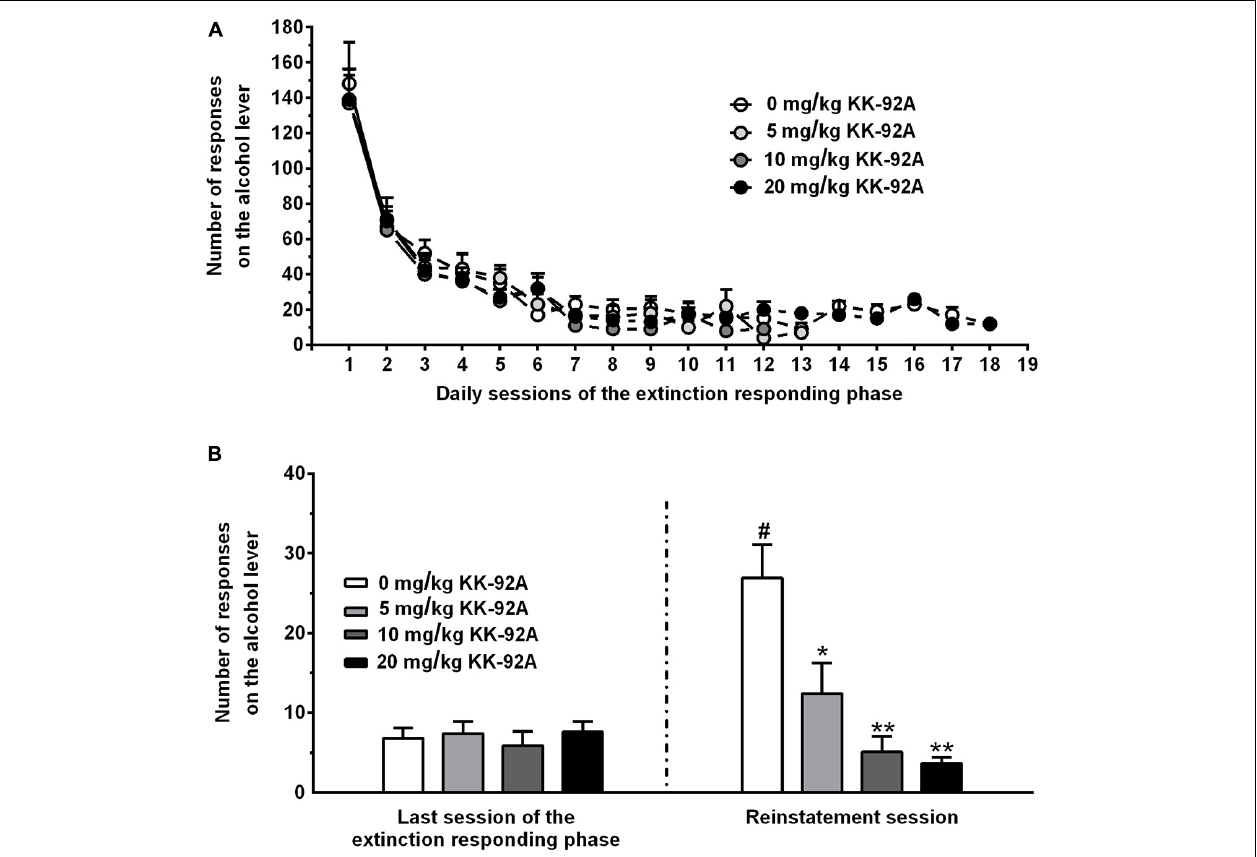
FIGURE 5 | Effect of acute treatment with the positive allosteric modulator of the GABA B receptor, KK-92A, on cue-induced reinstatement of alcohol-seeking behavior in female Sardinian alcohol-preferring rats. Rats were initially trained to lever-respond for oral alcohol (15% v/v, in water) [Fixed Ratio (FR) 5 (FR5)] and water (FR1) in daily 30-min self-administration sessions. Once lever-responding had stabilized, rats were exposed to an extinction responding phase (A) during which lever-responding was unreinforced. The reinstatement session occurred once each single rat had achieved the extinction criterion ( ≤ 12 responses on the alcohol lever per session for 2 consecutive sessions). In the reinstatement session (B) , unreinforced lever-responding was resumed by the repeated presentation of a complex of visual, auditory, gustatory, and olfactory stimuli previously associated with alcohol availability. The reinstatement session lasted 60 min. KK-92A was administered intraperitoneally 30 min before the start of the reinstatement session. In panel (A) , each point is the mean ± SEM of an n value varying from 7 to 8 in the first extinction-responding sessions to 2 in some of the last extinction-responding sessions (note that in some of these last sessions the sample size of the 20 mg/kg KK-92A-treated rat group was limited to n = 1). In panel (B) , each bar is the mean ± SEM of n = 7–8 rats. # P < 0.0001 in comparison to the same rat group in the last session of the extinction-responding phase (Bonferroni’s test); * P < 0.0005 and ** P < 0.0001 in comparison to the rat group treated with 0 mg/kg KK-92A in the reinstatement session (Tukey’s